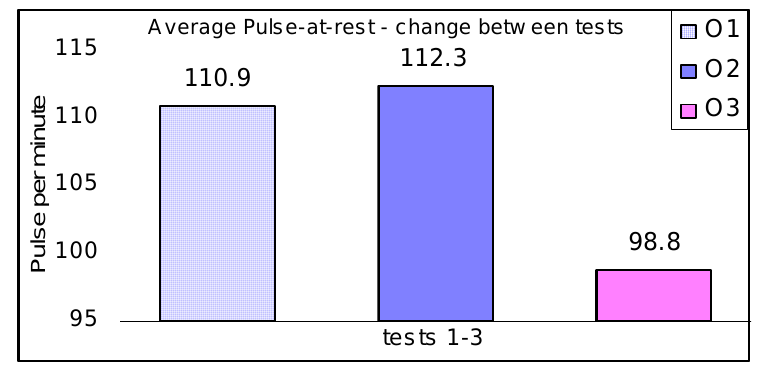
FIGURE 1 . Change in average pulse at rest across tests. The figure represents the average heart-at-rest scores for all participants (n = 15) at tests O 1 (2 months before program